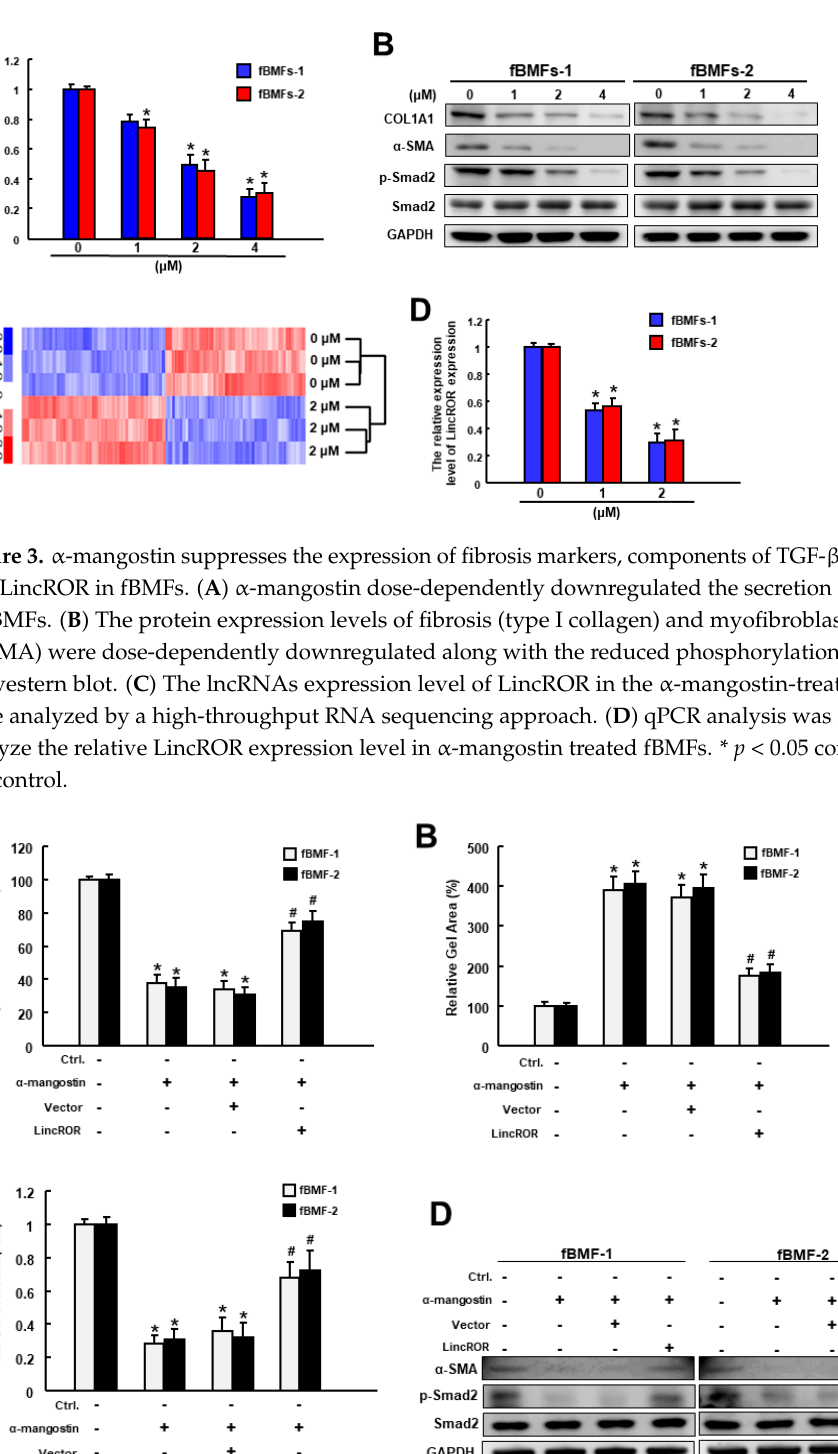
Figure 4. Ectopic expression of LincROR reverses the effects of α -mangostin on myofibroblast activities and TGF- β signaling. Administration of α -mangostin suppressed the transwell migration ( A ), collagen gel contraction ( B ), secretion of TGF- β 1 ( C ) and protein expression of α -SMA, phosphory- lated Smad2, and total Smad2 ( D ), whereas forced expression of LincROR abolished these effects. ∗ p < 0.05 compared to control. # p < 0.05 compared to α -mangostin-only group.